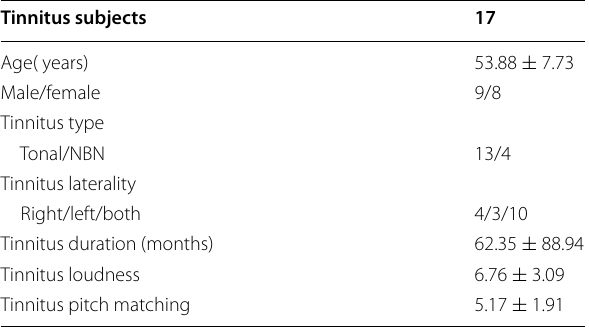
Table 1 The clinical and demographic features of tinnitus